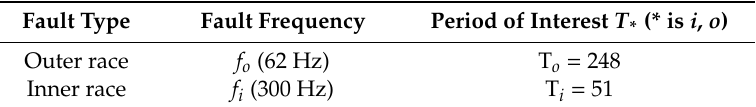
Table 4. The parameters T * (* is i , o ).